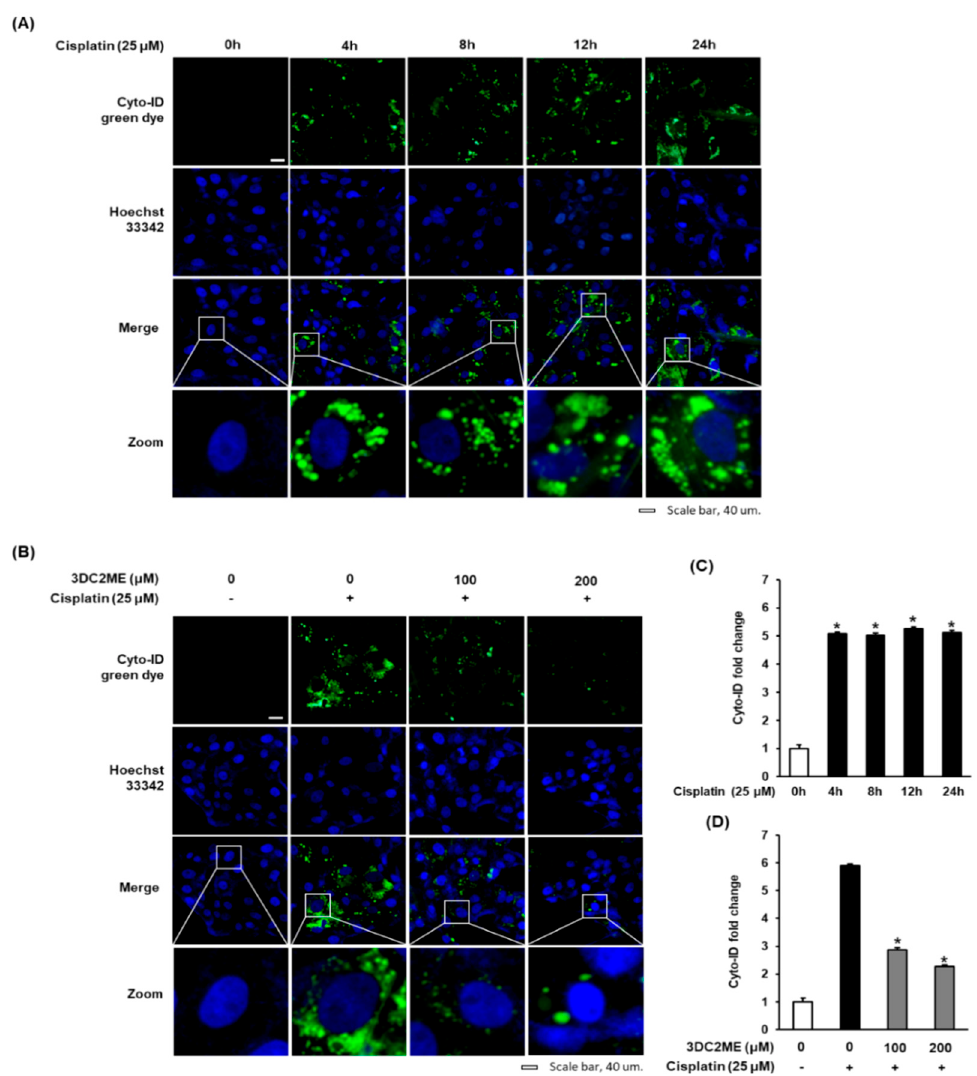
Figure 3. Effect of 3DC2ME isolated from Z. jujuba root extract on autophagic vacuoles in LLC-PK1 cells. ( A ) Representative images of autophagic LLC-PK1 cells stained with Cyto-ID ( green ) at various time points as indicated and exposed to 25 μ M cisplatin. Nuclei are counterstained with Hoechst 33342 dye ( blue ). ( B ) Representative images of autophagic LLC-PK1 cells exposed to 3DC2ME in the presence of 25 μ M cisplatin after staining with Cyto-ID (green) for 24 h. Nuclei were counterstained with Hoechst 33342 dye ( blue ). ( C , D ) Bar graphs indicated the fold of Cyto-ID ( green ) fluorescence intensity in each group as compared with control cells. Scale bar, 40 μ m (mean ± SD, * p < 0.05 cisplatin-treated LLC-PK1 cells). 3DC2ME, 3-dehydroxyceanothetric acid 2-methyl ester; SD, standard deviation.